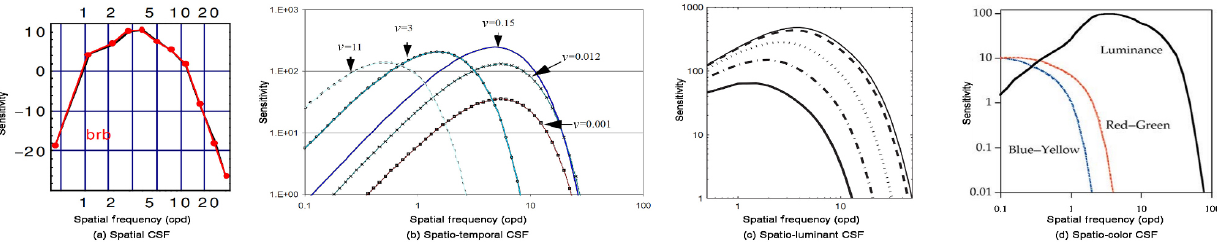
Fig. 4 CSFs over the range of spatial frequencies, temporal frequencies, luminances, and colors. (a) Spatial CSF with the measured data from Watson [80]. (b) Spatio-temporal CSF derived from sensitivity measurements in Yee et al. [81], where v is the velocities of the retinal images that measured in d/s. (c) Spatio-luminance CSF measured by Barten’s model in Westland et al. [82] for stimulus of size 10 cpd and mean luminance 50 (thin solid line), 25 (dashed line), 2.5 (dotted line), 0.25 (dashdotted line), and 0.025 (thick solid line) cd / m 2 . (d) Spatio-chromatic CSF for black–white, red–green, and yellow–blue contrast from Fairchild [83]. Reproduced with permission from Ref. [80], c (cid:13) Optical Society of America 2000; Ref. [81], c (cid:13) ACM 2001; Ref. [82], c (cid:13) Wiley Periodicals, Inc. 2006; Ref. [83], c (cid:13) John Wiley and Sons